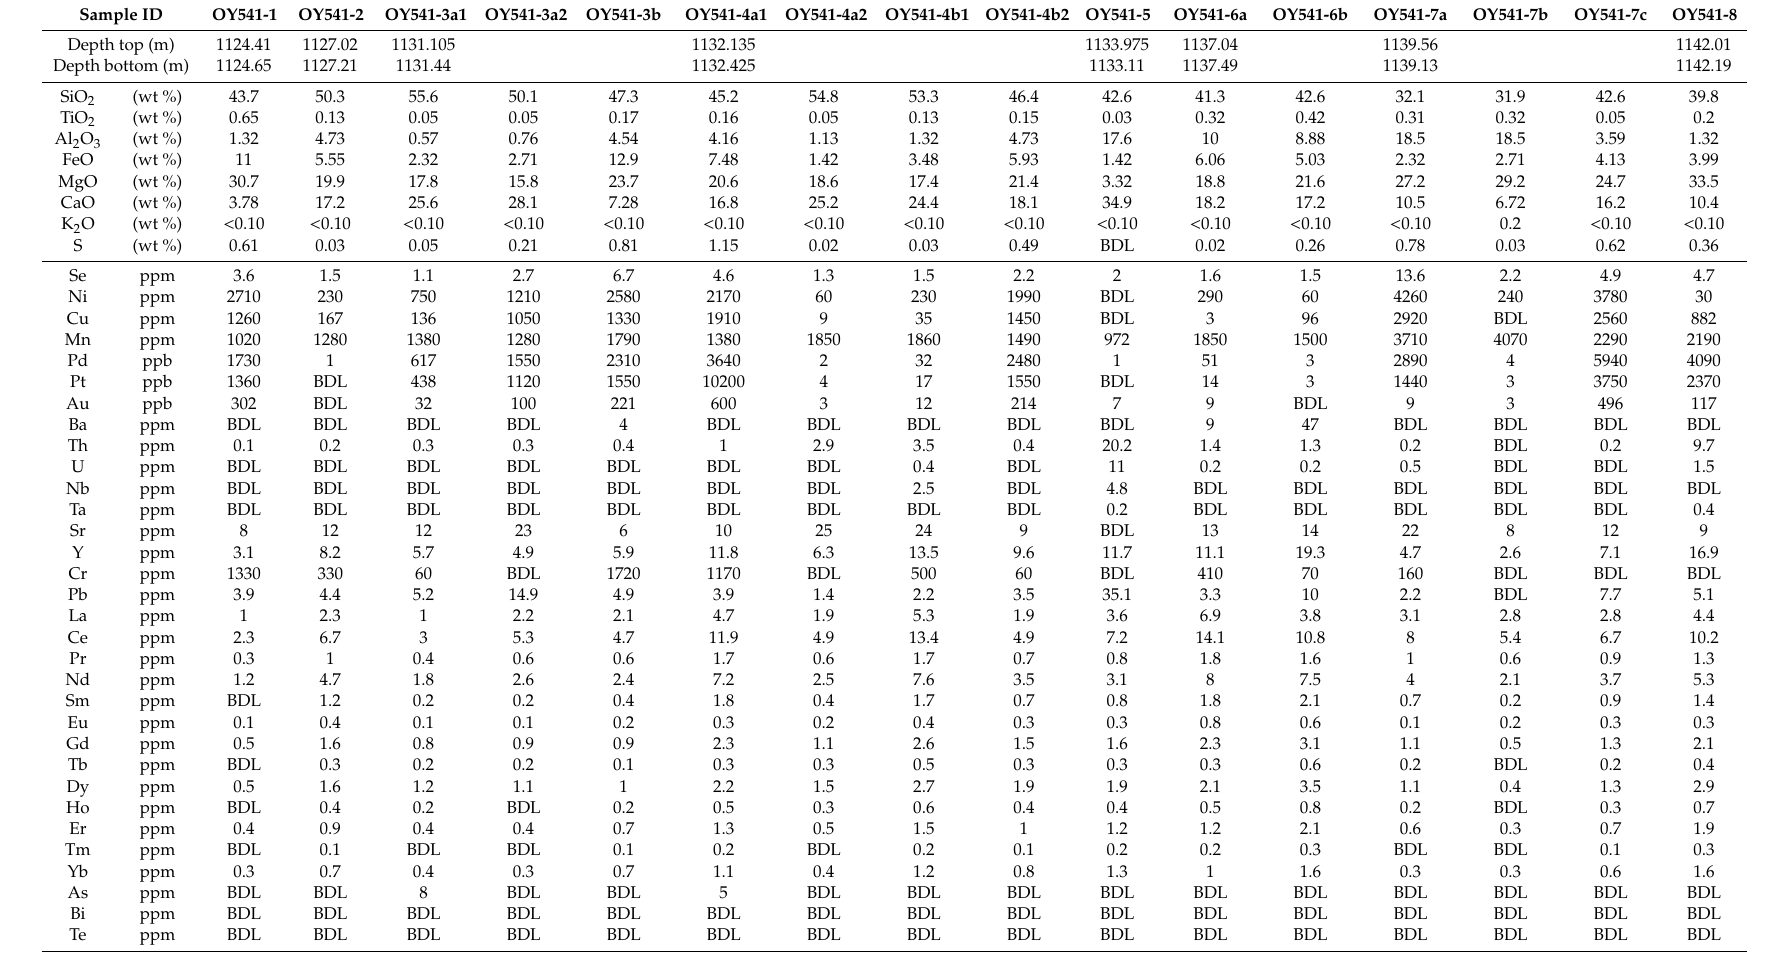
Table 1. Bulk rock compositions of the clinopyroxenite samples from drill core